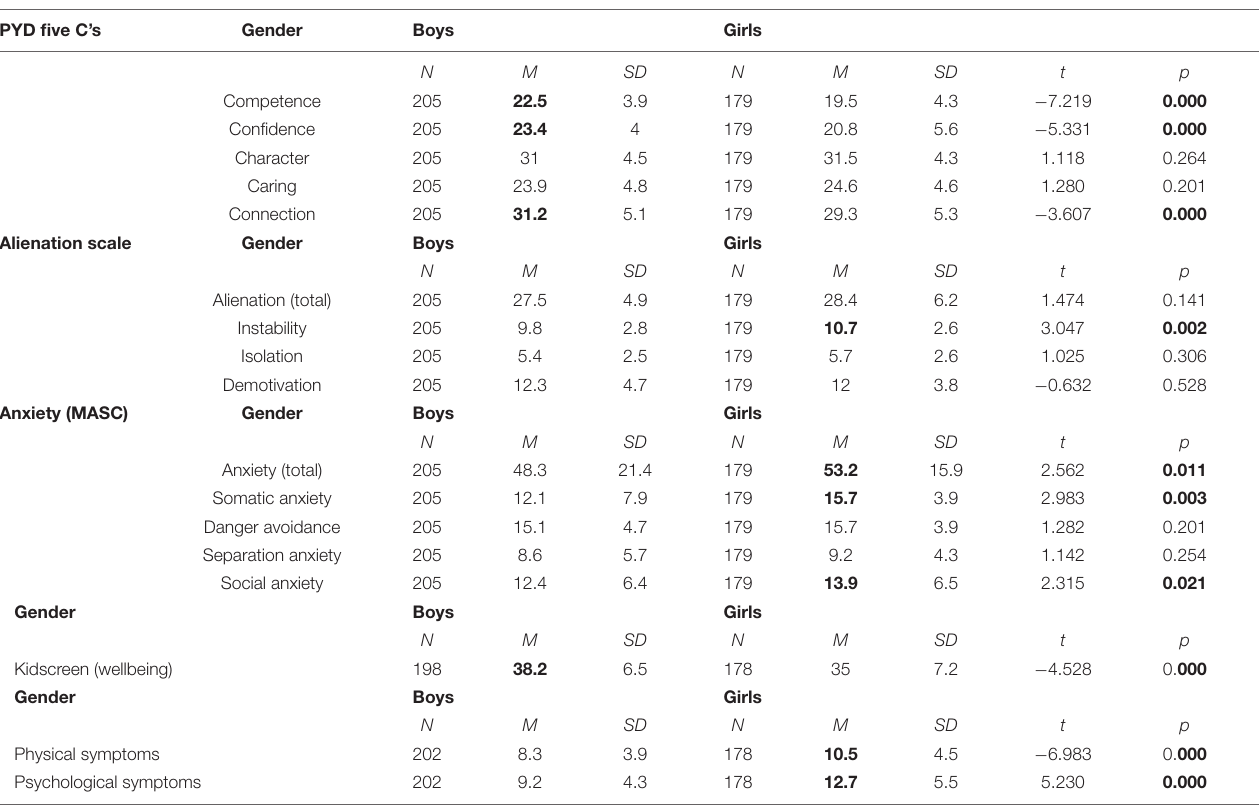
TABLE 2 | Gender differences—five C‘s and wellbeing (ANOVAS). PYD five